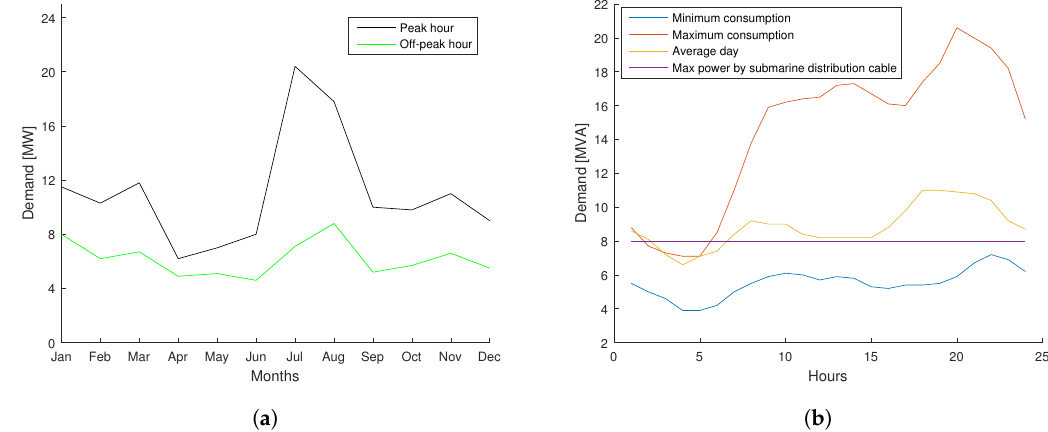
Figure 3. Demand at the island Lošinj in 2016. ( a ) Demand during peak and off-peak hours. ( b ) Characteristic Wednesdays: (i) minimum (April), (ii) average (November) and (iii) maximum